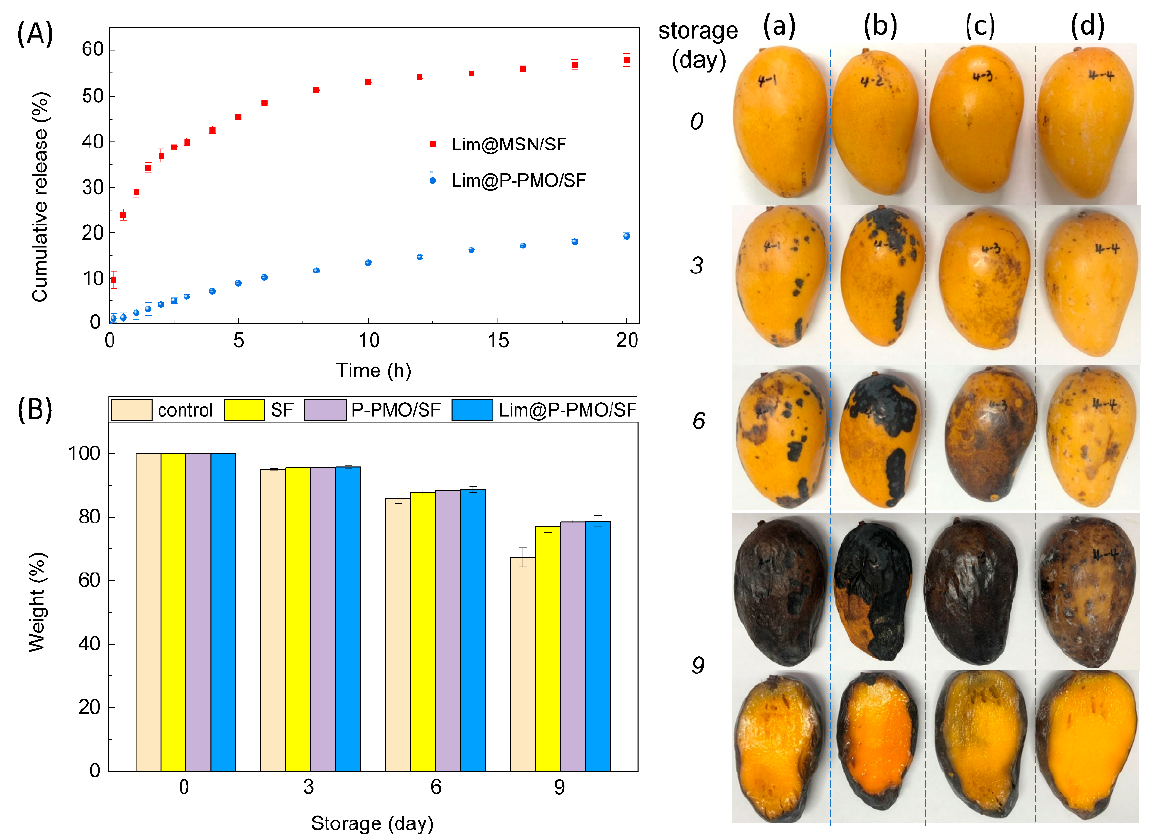
Figure 4. ( A ) Release profiles of SF ‐ coated NPs ( ■ ) Lim@MSN/SF and ( ) Lim@P ‐ PMO/SF under isothermal TGA conditions (30 °C, a N 2 flow at 1.0 mL min − 1 ). The samples were obtained by dipping Lim@MSN or Lim@P ‐ PMO (LC = 38 ± 1%) in a 4% ( w / v ) silk fibroin solution (25 °C, 1 min) followed by freezing and lyophilization. ( B ) Change in weight of mangoes with different coatings and un ‐ coated samples during storage at ambient temperature 30–35 °C and 75–85% RH. Right panel: visual appearance of mango samples during storage, respectively, coated with ( a ) SF, ( c ) P ‐ PMO/SF, ( d ) Lim@P ‐ PMO/SF, and ( b ) without coating as a control. Error bars represent the standard deviation.